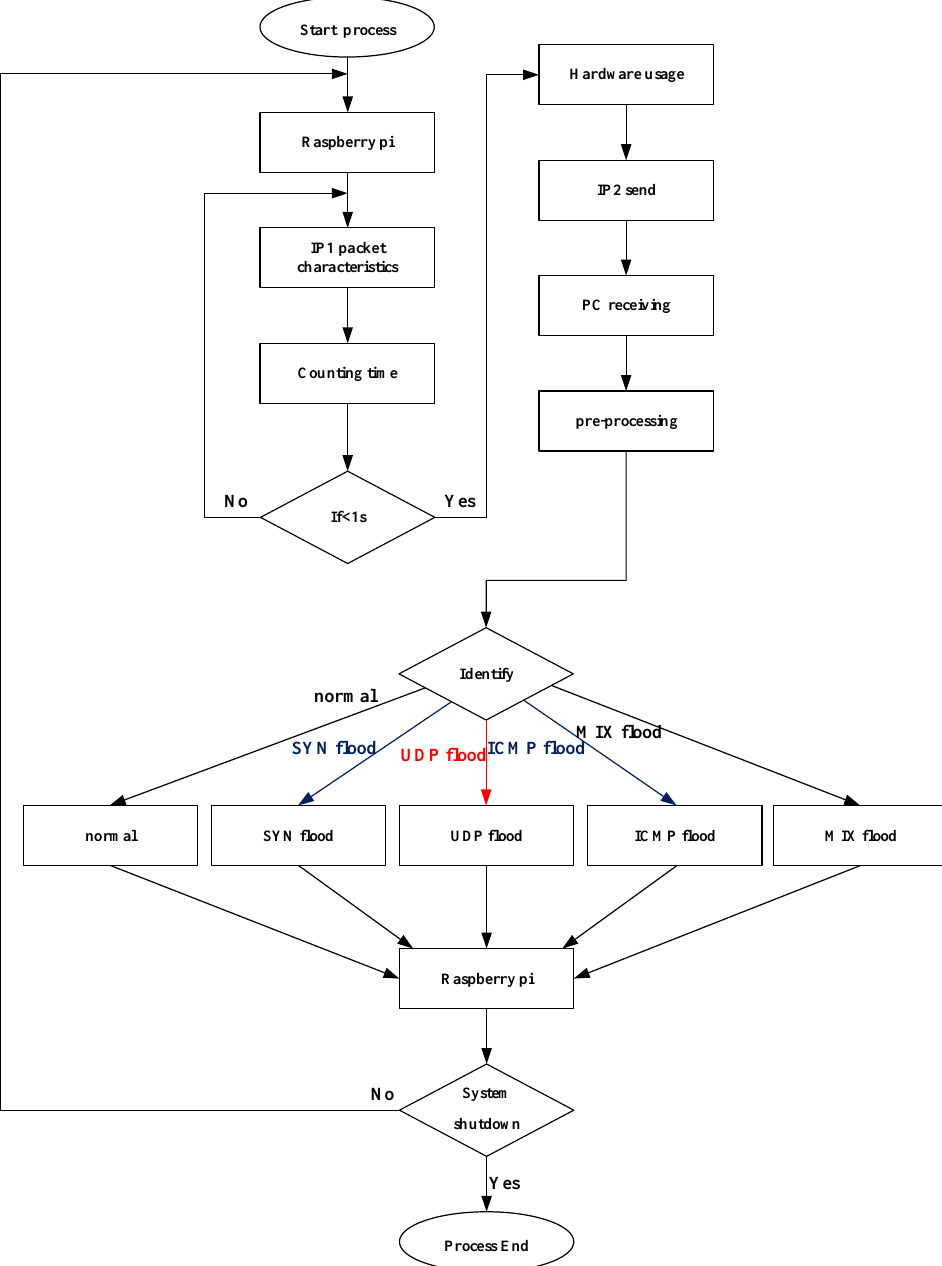
Figure 15. Procedure from packet receiving to edge computing.